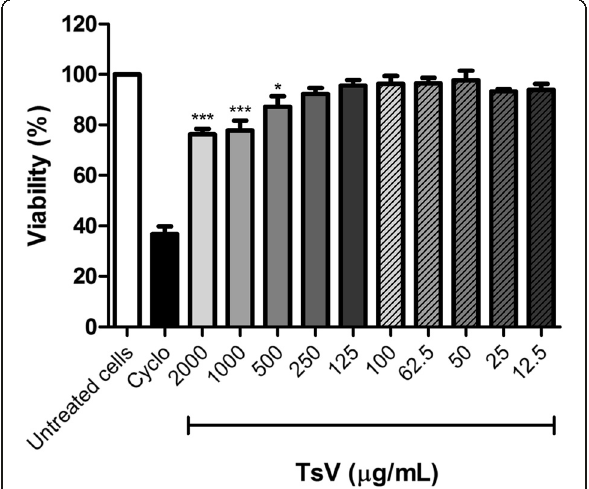
Fig. 1 Effect of Tityus serrulatus scorpion venom (TsV) on peripheral blood mononuclear cell (PBMC) viability. PBMC (5 × 10 5